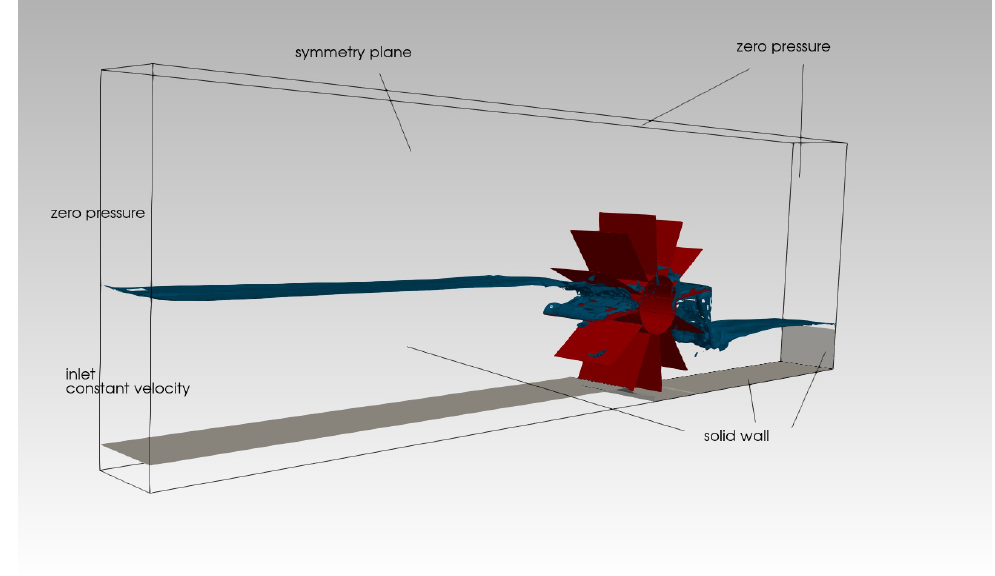
Figure 6. Boundary conditions of the computational